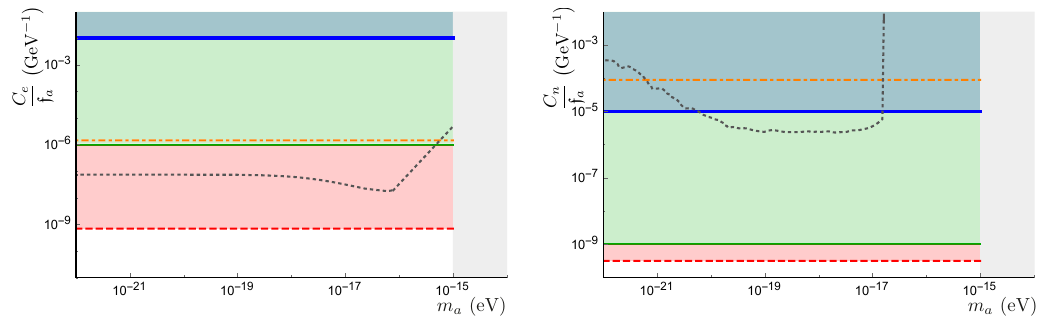
Figure 4 . Expected bounds for the coupling of axion DM fields to electrons (left) and nucleons (right). The thick-solid (blue) lines represent atomic clocks, while the thin-solid (green) line are constraints from magnetometers. The dotted-dashed (orange) lines represent the bounds from fifth- force experiments [99] (e) and [100] (n). The red dashed lines represent the bounds coming from energy loss in stars [101]. Finally, the dotted (black) lines are expected [54] (e) and current [102] (n) laboratory bounds.